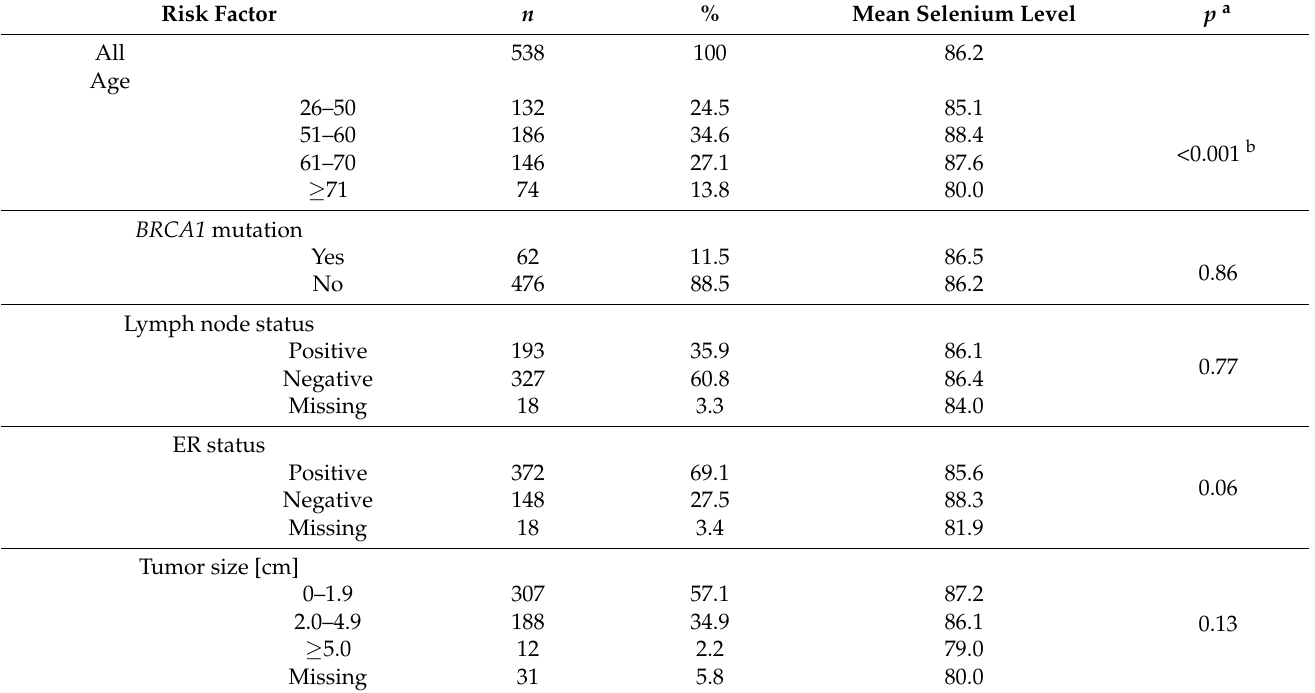
Table 1. Mean serum selenium levels by various treatment, clinical